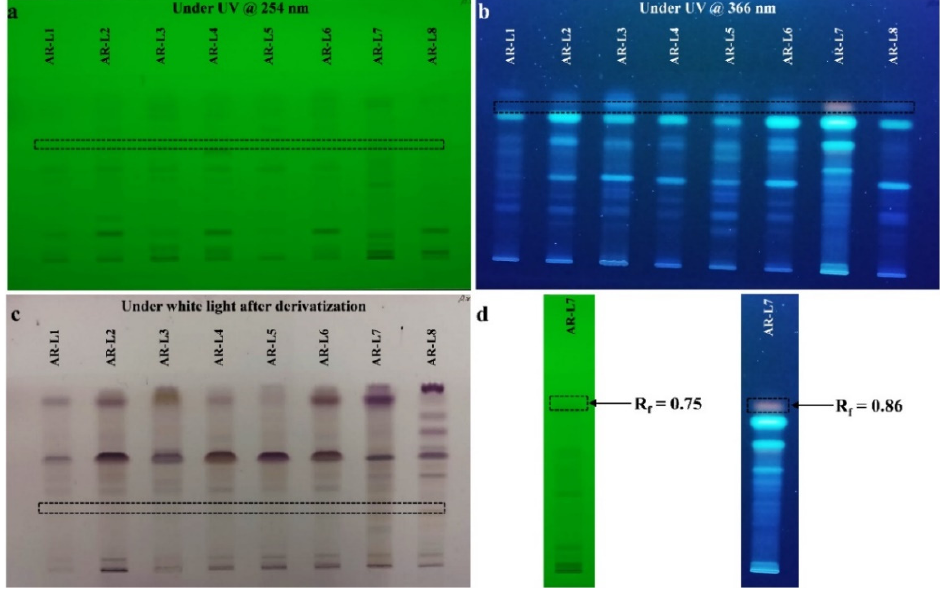
Figure 2. HPTLC fingerprint profiling of EA extract of fungal endophytes. ( a ) Image of TLC plate at 254 nm, ( b ) image of TLC plate at 366 nm, ( c ) image of TLC plate under white light after derivatization with anisaldehyde sulphuric acid reagent and ( d ) HPTLC fingerprint profiling of EA extract of P. oxalicum showing unique bioactive component with respective value of retention factor (R f ).